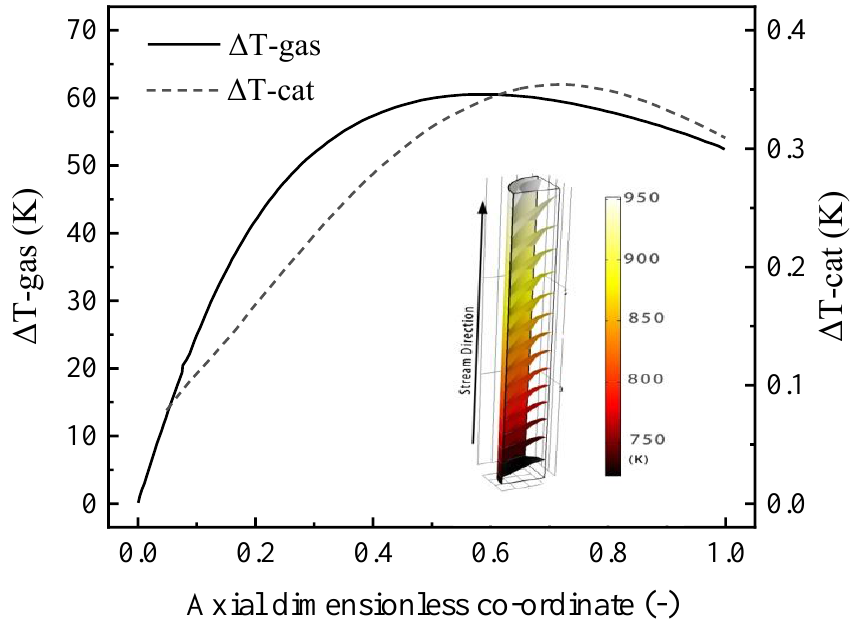
Figure 10. Transverse temperature differences along the length of the reforming channel between the combustion catalyst and the reforming catalyst (ΔT-cat.) and that between the reforming catalyst and the gas phase center (ΔT-gas).